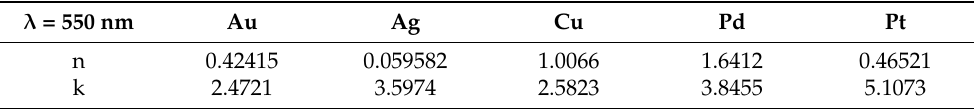
Table 1. Values for the real part, n, and imaginary part, k, of the refractive index of the materials composing the core–shell particles (corresponding to the electromagnetic radiation wavelength λ = 550 nm) and used for the calculations [71]. λ = 550 nm